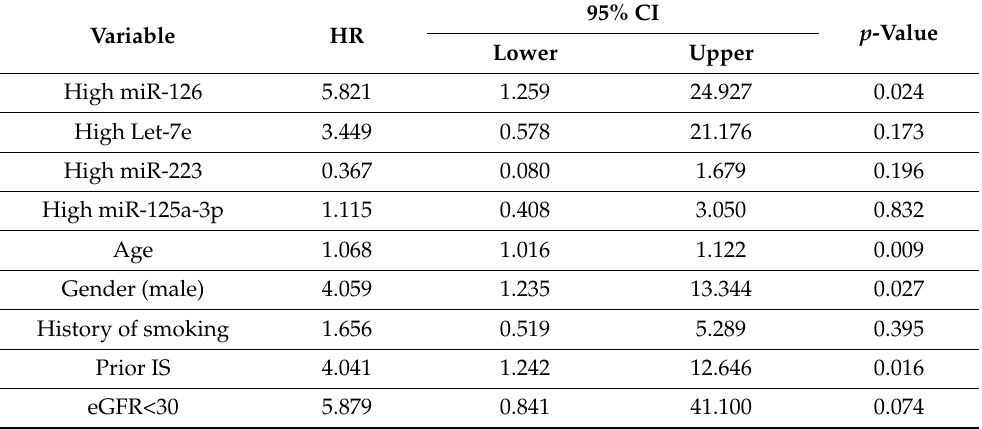
Table 4. Multivariate Cox regression model including high levels of miRNAs and clinical